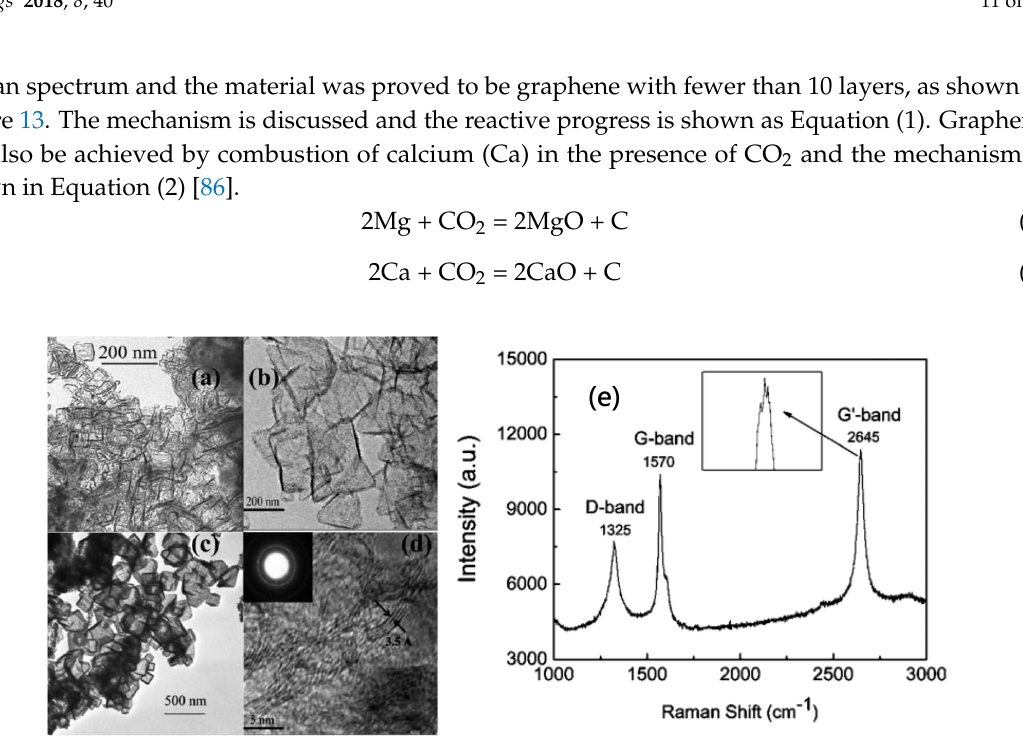
Figure 13. Characterized images of graphene via combusting Mg in the CO 2 atmosphere. ( a – d ) TEM images under different scales; ( e ) Raman spectrum. (Reproduced from [85] with permission; Copyright 2011 The Royal Society of Chemistry.)